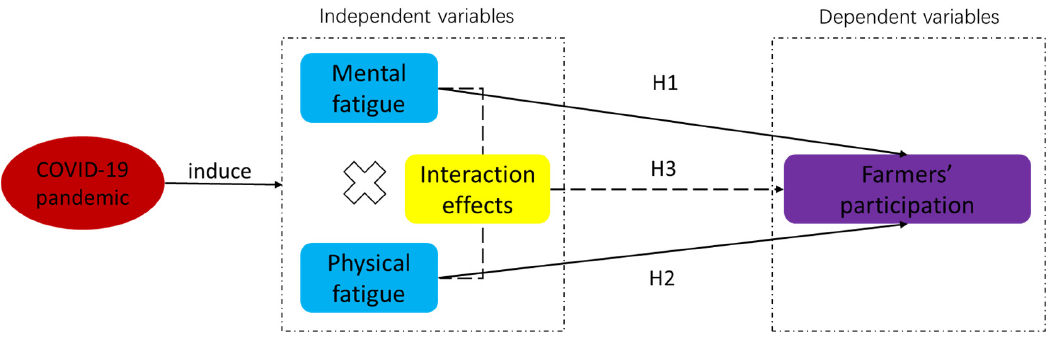
Figure 1. A conceptual model of hypothesized relationships. Note: the red oval represents the stimuli, the blue rectangles represent dependent variables, the grey rectangle represents independent variables, and the yellow rectangles represent the interaction effects of mental and physical fatigue.